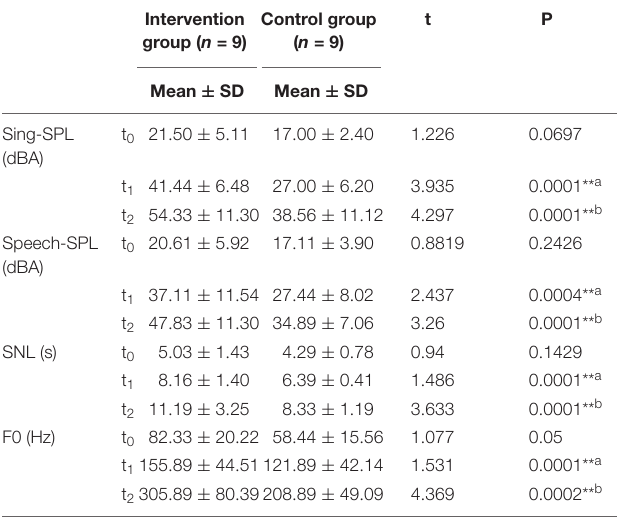
TABLE 2 | Vocal quality results in CSCI patients across the study period for the intervention and control